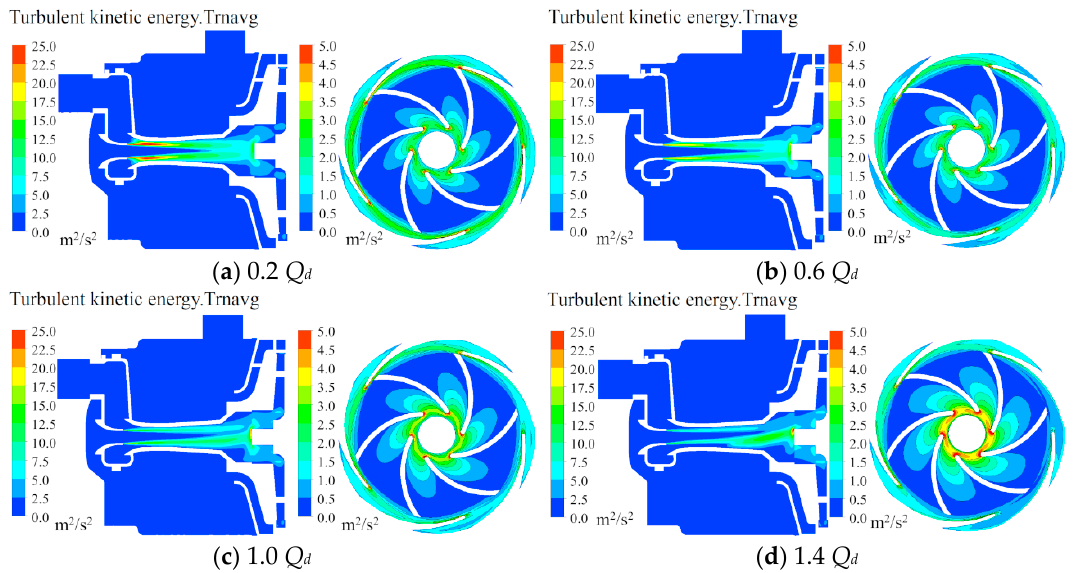
Figure 7. Time-averaged distribution contours of turbulent kinetic energy on two planes under four conditions.